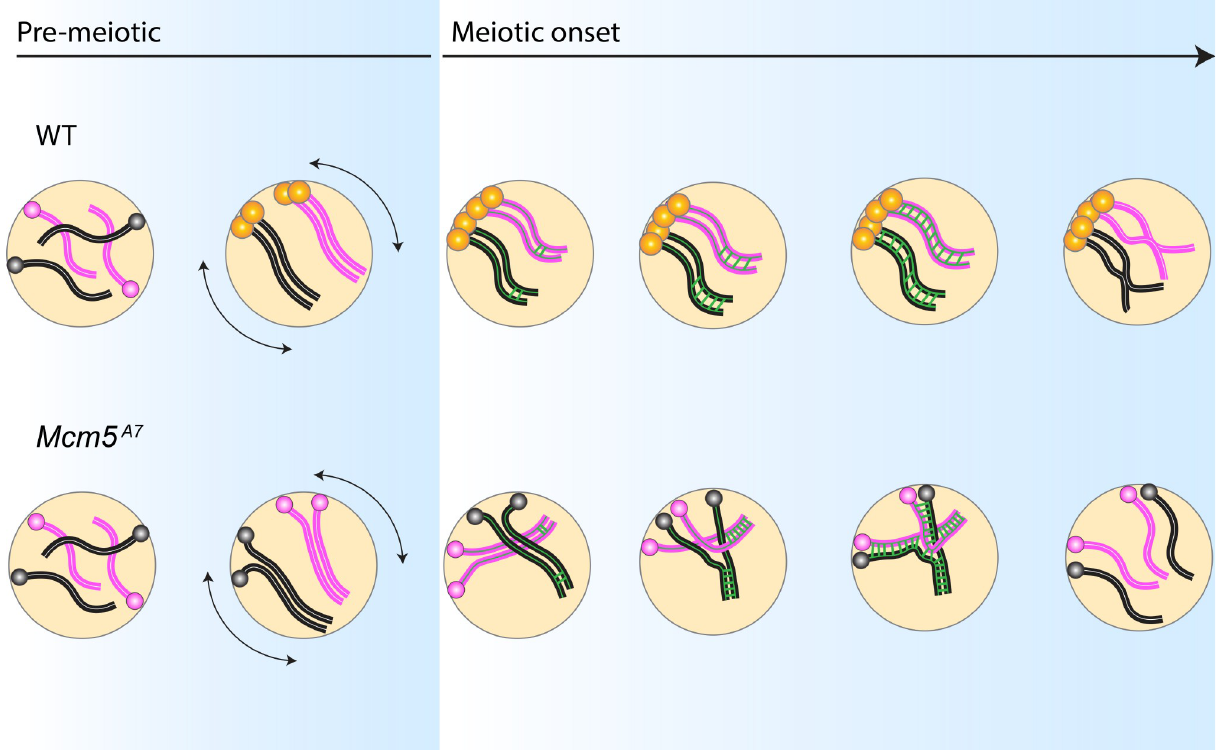
Fig 7. Centromeric SMC1-dependent pairing model. WT : In pre-meiotic cysts, homologous chromosomes (pink = homolog pair 1, black = homolog pair 2) enter the germline unpaired. During pre-meiotic cell cycles, chromosome arms and centromeres pair, with centromeres anchored at the nuclear envelope. Prior to meiotic onset, SMC1 is enriched at the centromeres (yellow) and centromere-directed chromosome movement (double-headed arrows) occurs. These events yield centromere clustering at meiotic initiation. As euchromatic synapsis nucleates along arms (green bars), paired chromosomes are stabilized by centromere clustering, permitting homosynapsis. After DSB formation and repair (not depicted), crossovers between homologs are formed, promoting proper disjunction at the end of meiosis I. Mcm5 A7 : Chromosomes enter the germline unpaired, and centromeres are attached to the nuclear envelope. In pre-meiotic cycles, chromosomes initially pair, but centromeres do not. Centromere-directed chromosome movements occur, but SMC1 is not enriched at the centromere, causing a lack of centromere clustering at meiotic onset. As the SC nucleates at the arms, homolog pairing is not maintained. Synapsis spreads between the nearest chromosomal regions, independent of homology, yielding high frequency of heterosynapsis. During heterosynapsis, DSBs are not repaired by HR, yielding non-recombinant chromosomes that nondisjoin at the end of Meiosis